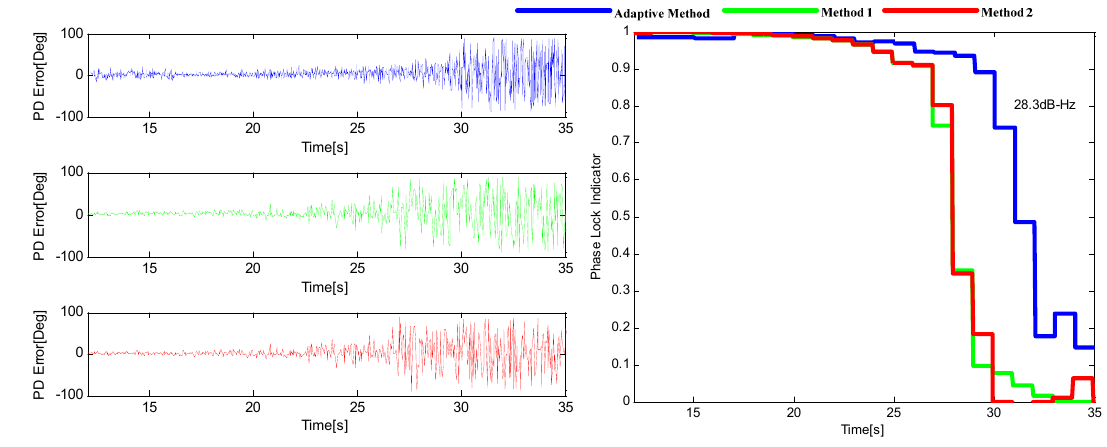
Figure 14. The output of PD ( left ) and the corresponding PLI ( right ) when p = 50 m/s 3 .